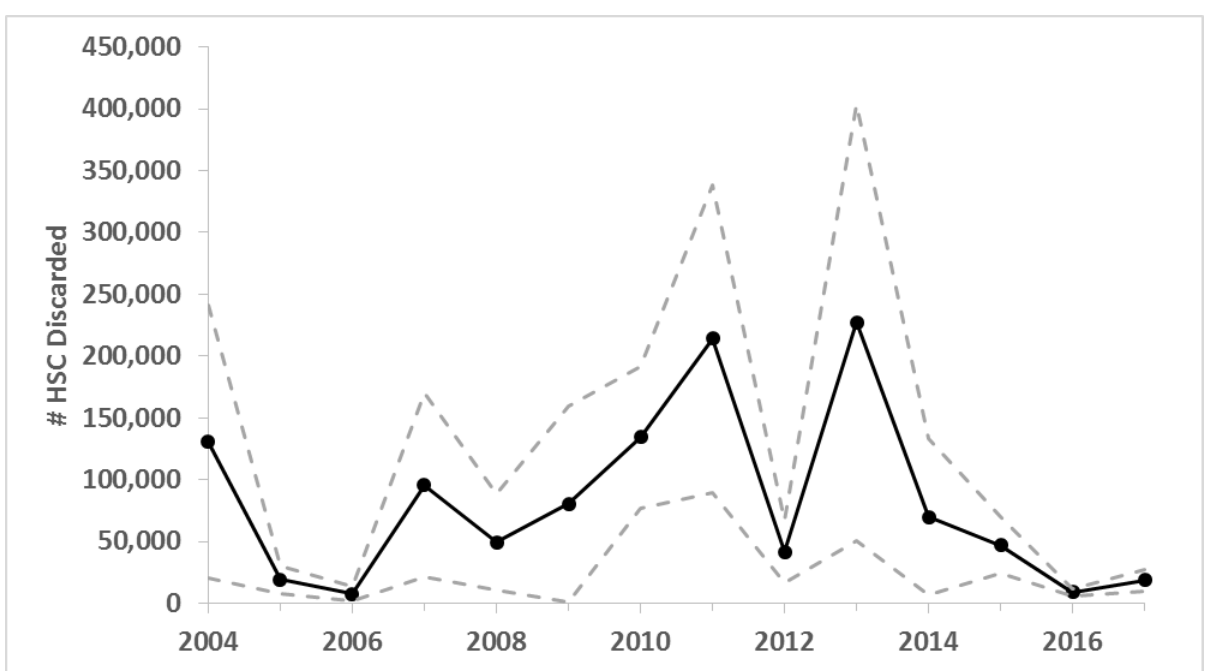
Figure 16. Estimated number of horseshoe crabs discarded from gill nets in the Delaware Bay region, 2004-2017, with 95% confidence